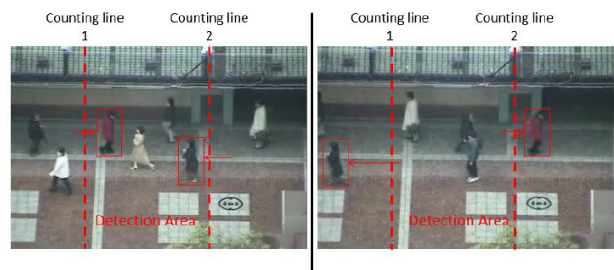
Figure 7 . Intelligent statistics process of human